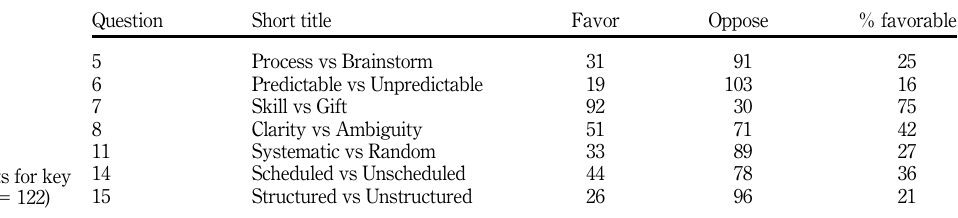
Table I. Key survey questions